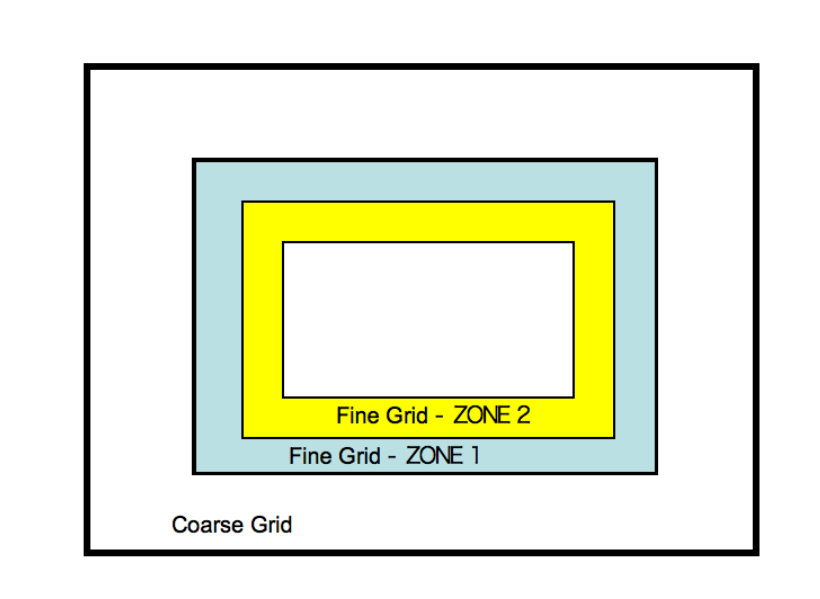
Figure 7.6: Zones of topographic blending for a fine grid. In the fine grid, the first zone is entirely interpolated from the coarse grid topography. In the second zone, the topography is linearly weighted between the coarse grid and the fine